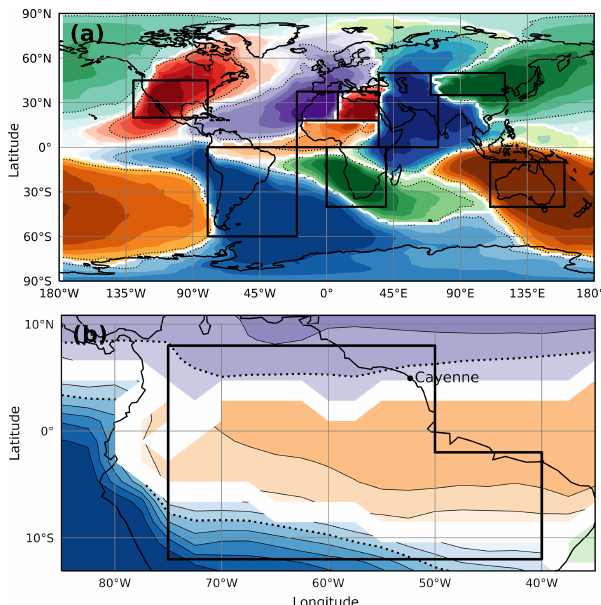
Figure 8. Percentage of dust deposition supplied by the dominant source region at each location for (a) the entire globe and (b) the Amazon rainforest. Different colors represent different dominant source regions, with shading decreasing in 10% increments from a maximum of 100% to a minimum of 20%. The 50% contour is identified by a black dotted line, and white shading denotes areas where two or more dust source regions contribute similarly to the deposition flux. The black boxes in panel (a) denote the nine major source regions, and the black box in panel (b) denotes the bound- aries of the Amazon rainforest used here based on Yu et al. (2015). Also shown is (b) Cayenne, the location of the field site where Pros- pero et al. (2020) obtained dust measurements (see